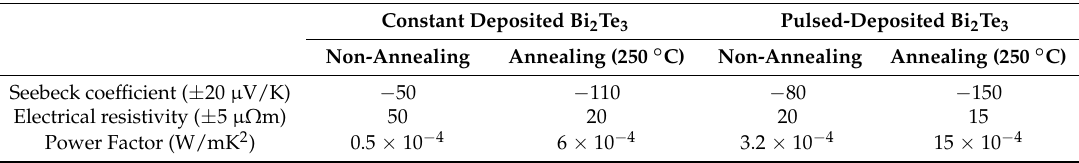
Table 1. Effects of annealing on the Bi 2 Te 3 properties.